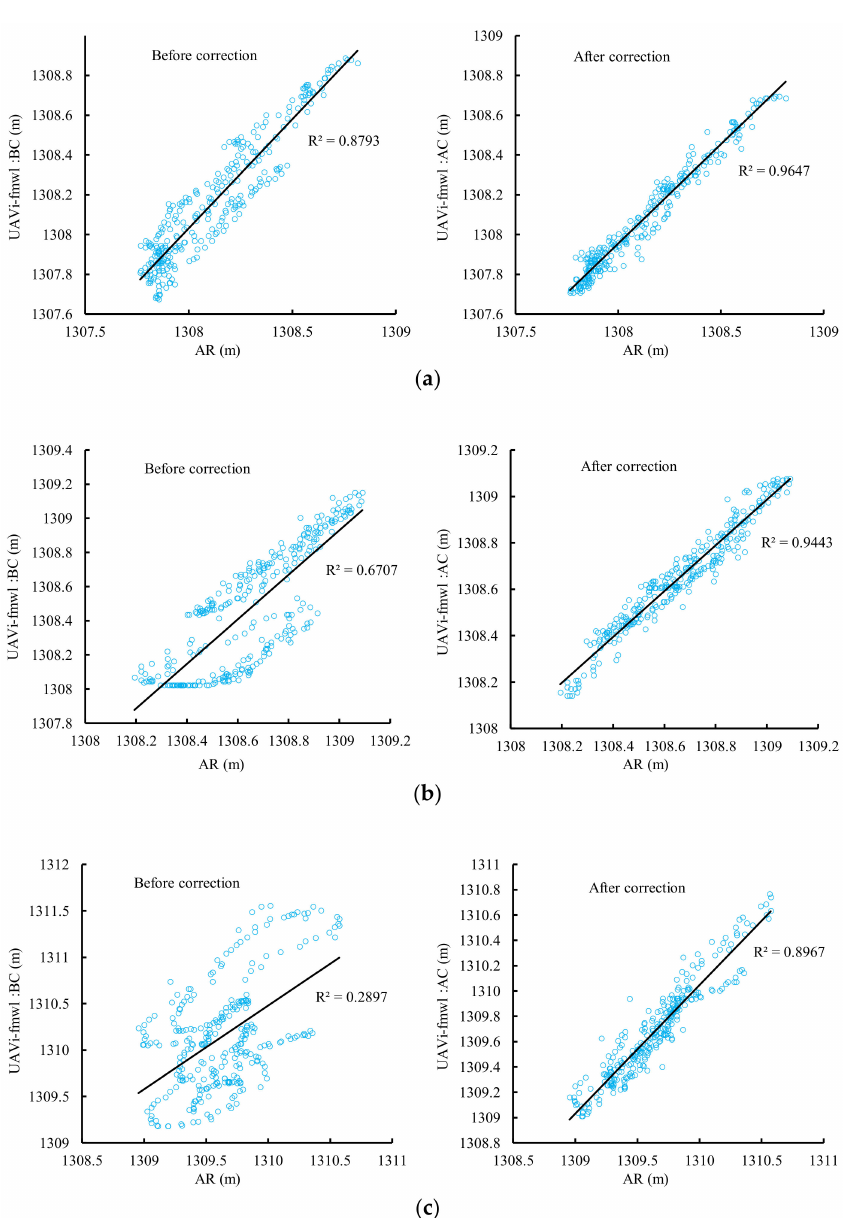
Figure 11. Consistency analysis between AR data and UAVi-fmwl data. ( a ) Q = 341 m 3 /s; ( b ) Q = 643 m 3 /s; and, ( c ) Q = 1249 m 3